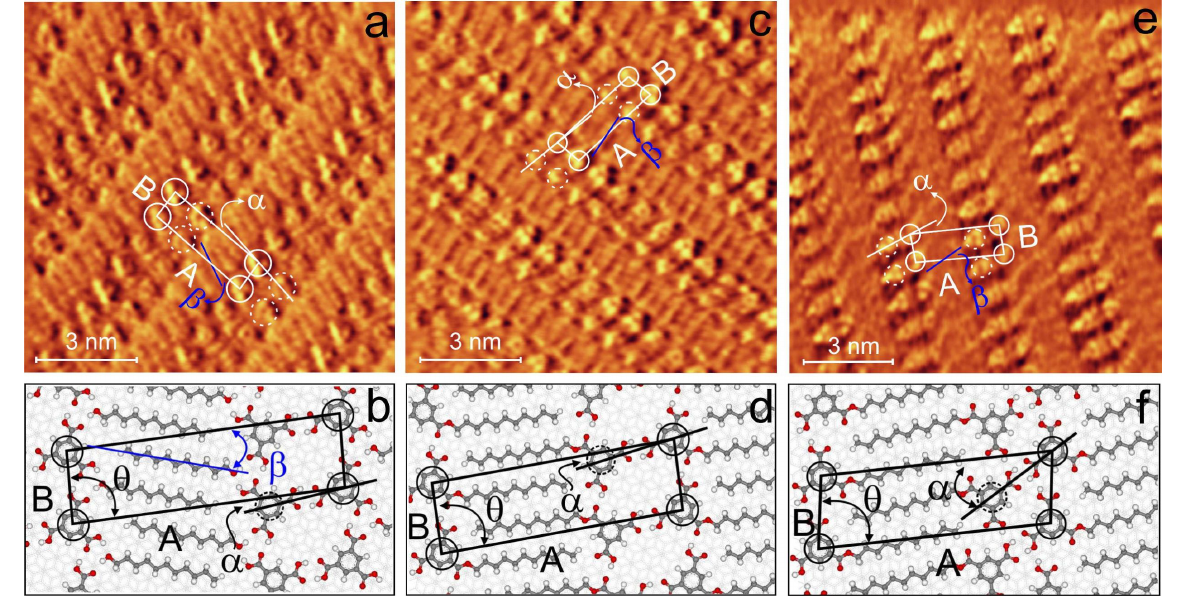
Figure 3: STM constant height image (1.2 V, 1 nA) of linear pattern LP4 (a), monoester type-I (c), and monoester type-II (e) deposited from a TMA–undecanol solution sonicated for 4 h. The unit cell is depicted by a parallelogram in STM images and A and B are the corresponding unit cell pa- rameters. The blue line indicates the orientation of undecanol (a) or undecyl chains of the ester molecule (c, e) with respect to the long side of the unit cell within the lamella. Force field optimized geometries of the linear pattern (b) and patterns formed by monoesters (d, f). In the models, solid circles indicate TMA (TMA head group in the case of ester) at the corners of the unit cells and dashed circles indicate the second TMA (TMA head group) of the dimer